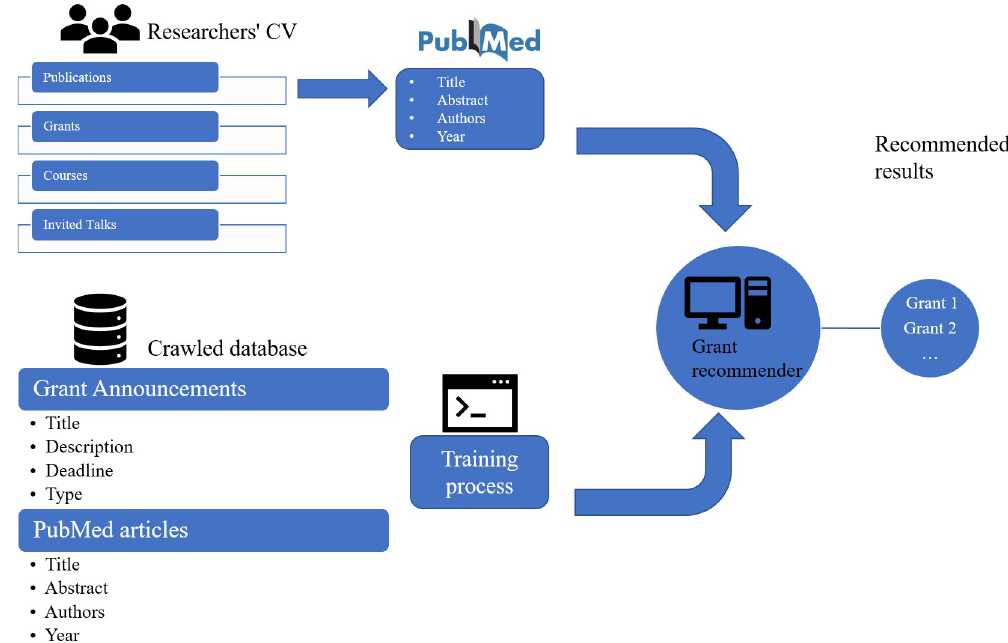
Fig 5. Overview of our grant recommender system